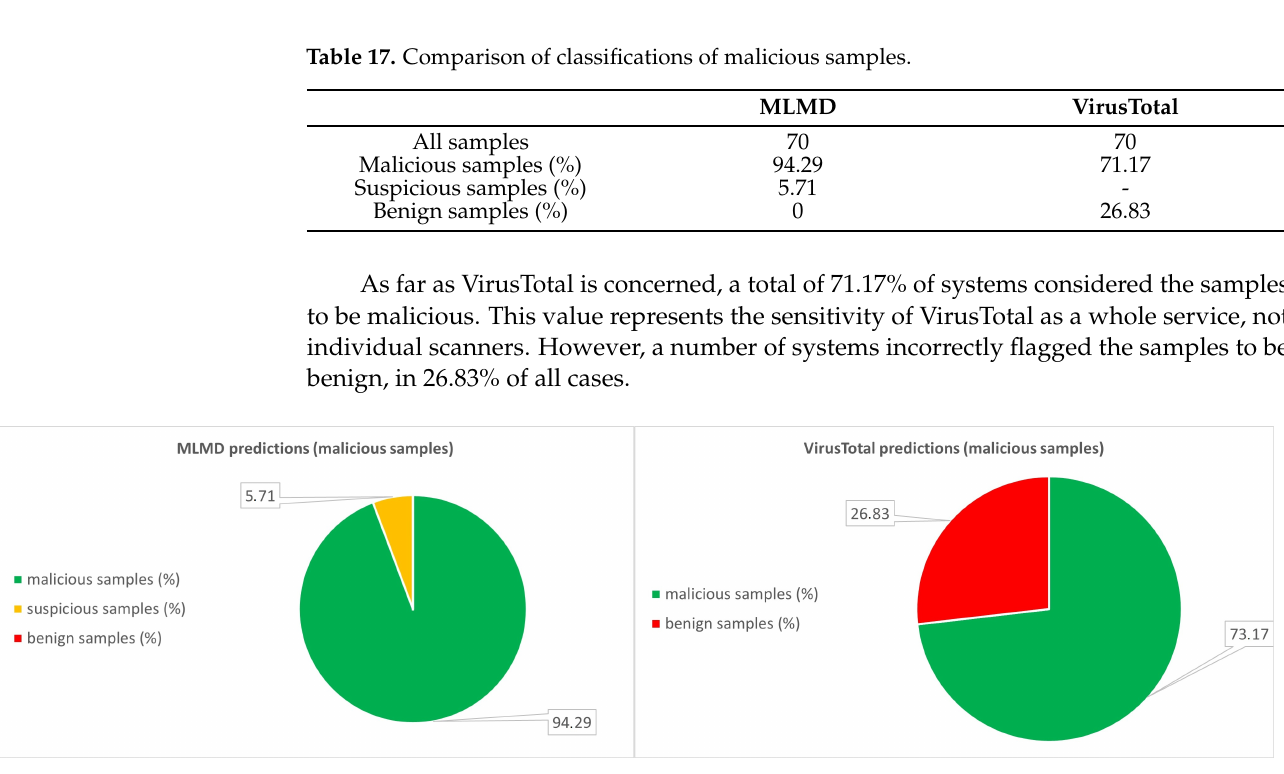
Figure 11. Comparison of predictions of malicious samples.